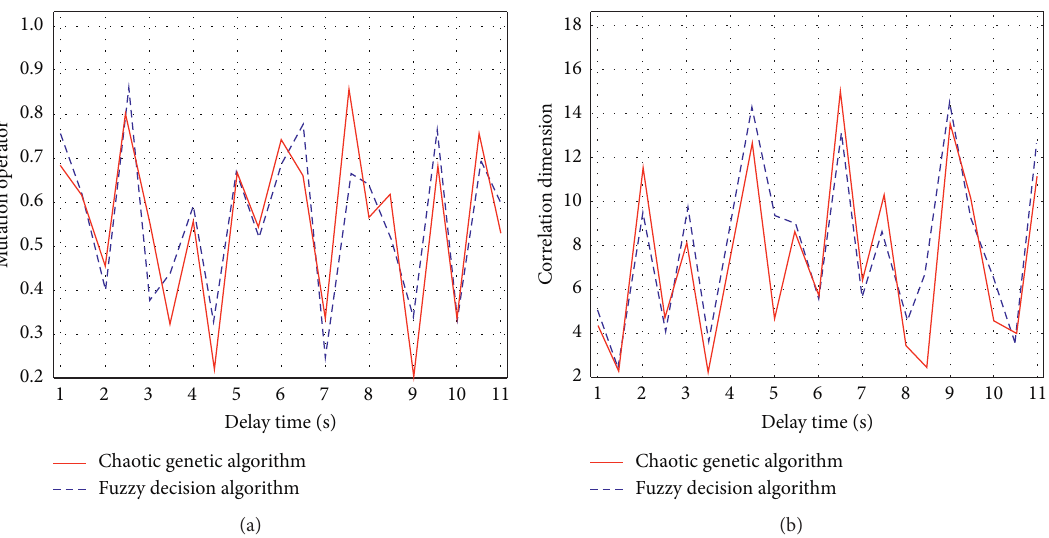
Figure 6: Relationship between delay time with mutation operator (a) and correlation dimension (b) of chaotic genetic and fuzzy decision algorithm.